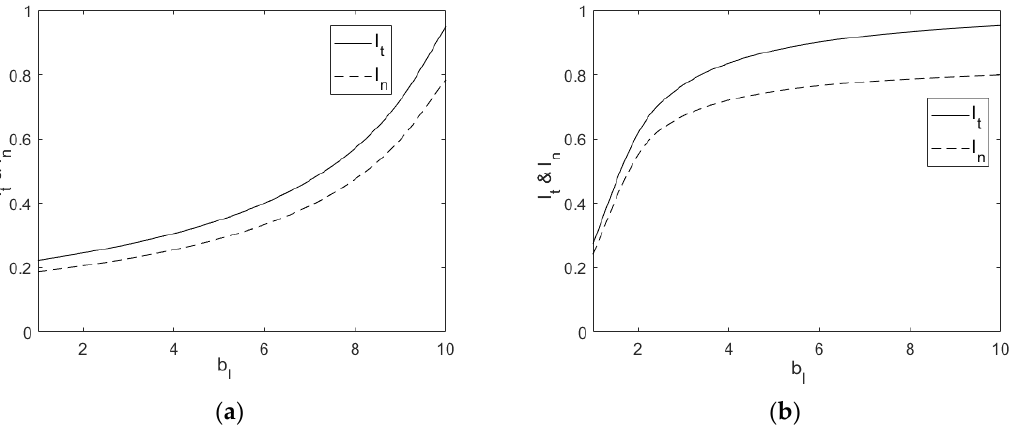
Figure 4. Impact of user preference on the investment and production of renewable energy: ( a ) the scenario of direct sale of power; ( b ) the scenario of purchase and sale by large power grids.